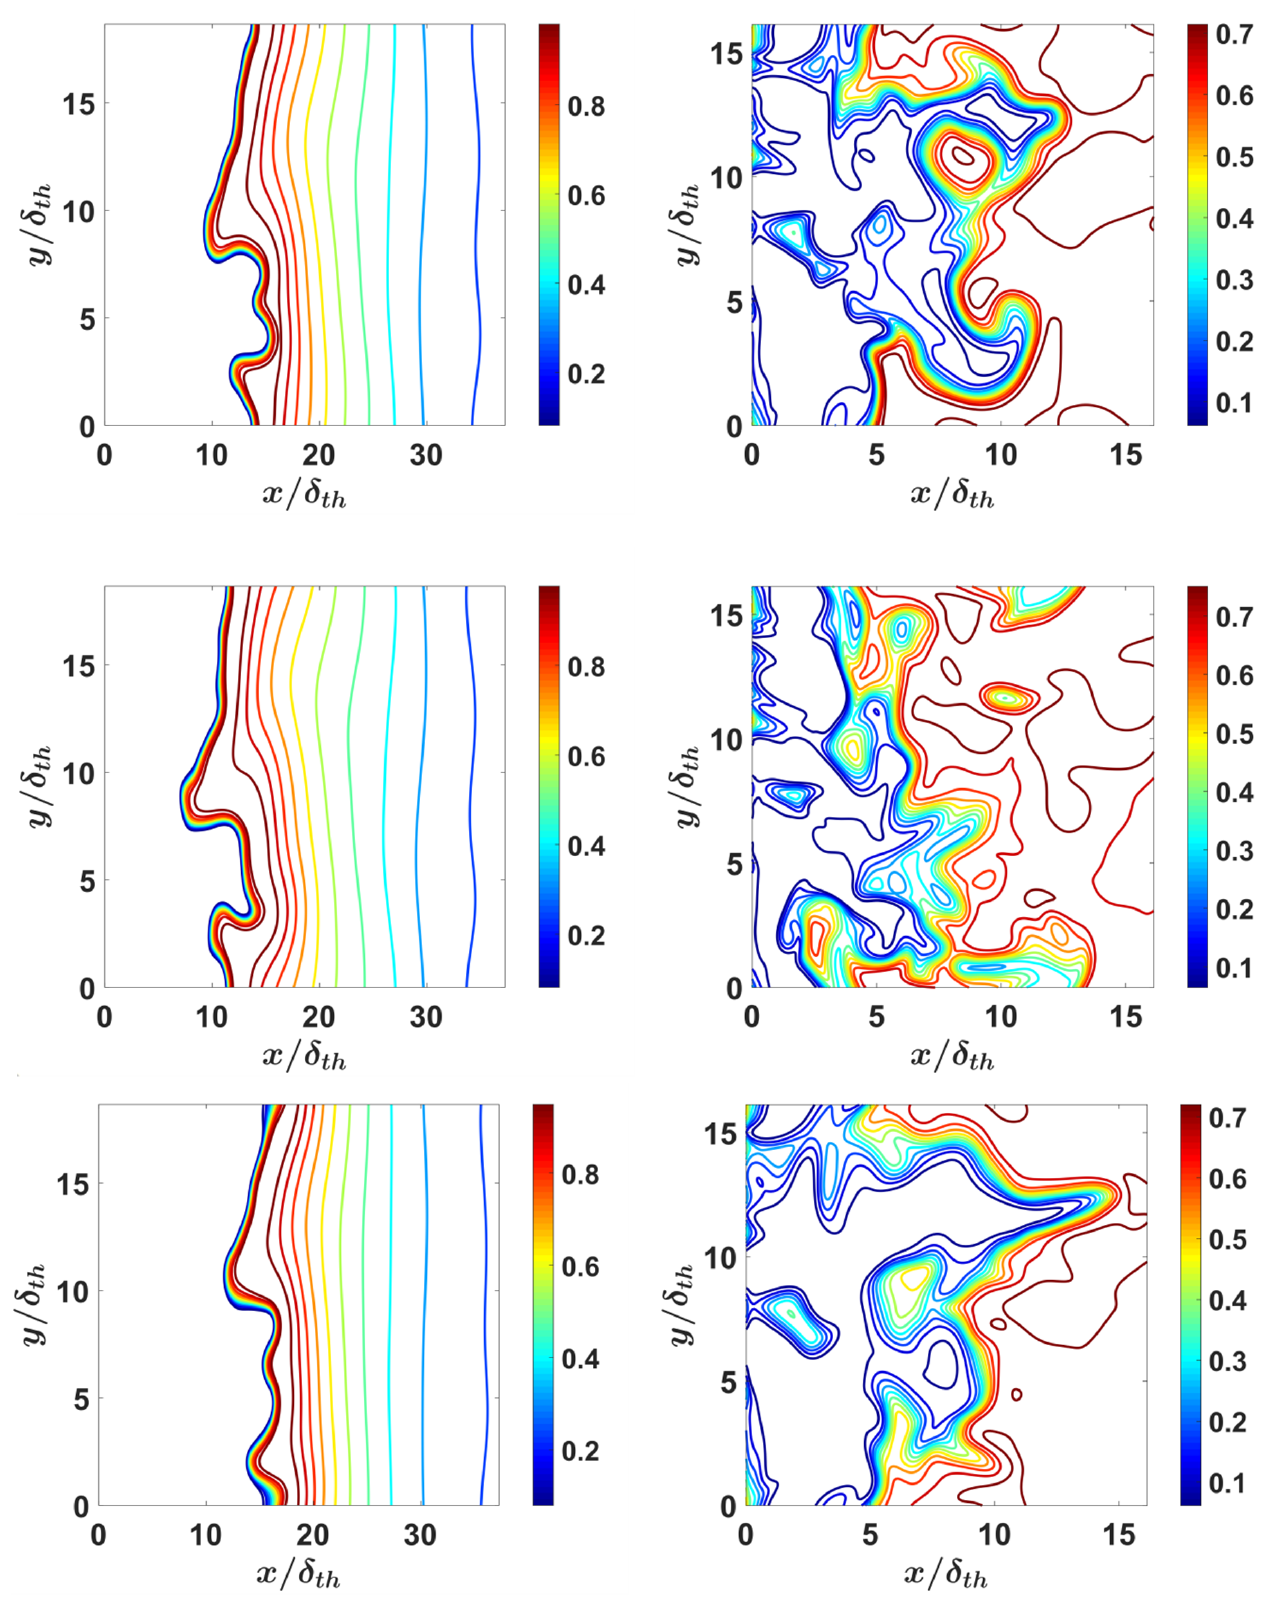
Figure 4. Contours of a normalised OH-PLIF signal S OH / [ S OH ] premixed flames (first column) and homogeneous MILD combustion cases (second column) for initial u (cid:48) / S L = 4.0, 6.0 and 8.0 (first–third